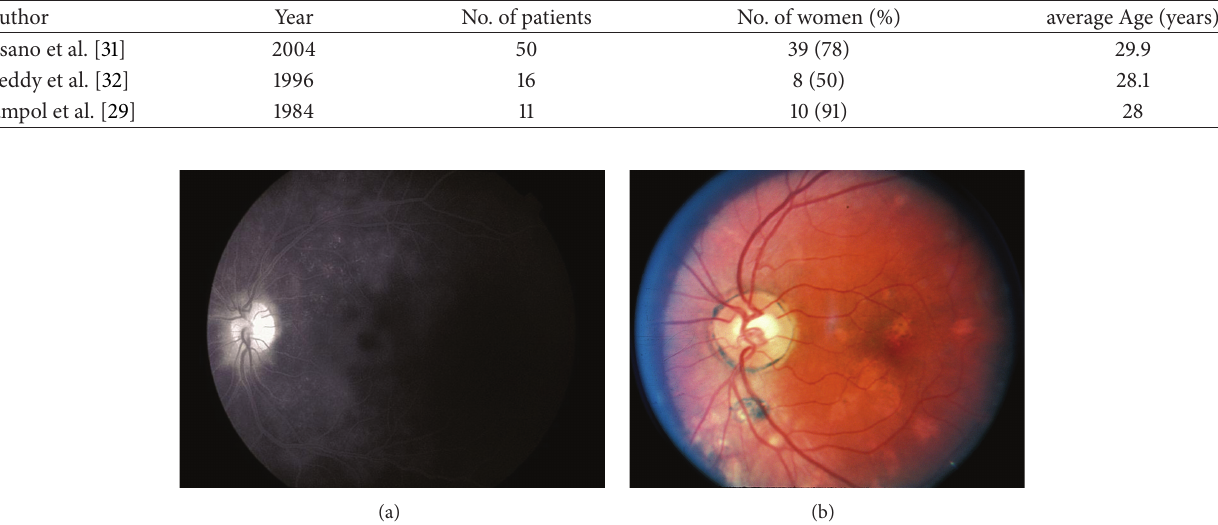
Figure 4: (a) Fluorescein angiogram of a patient with MFC demonstrating concurrent macular edema. (b) Fundus photograph of a patient with MFC requiring systemic